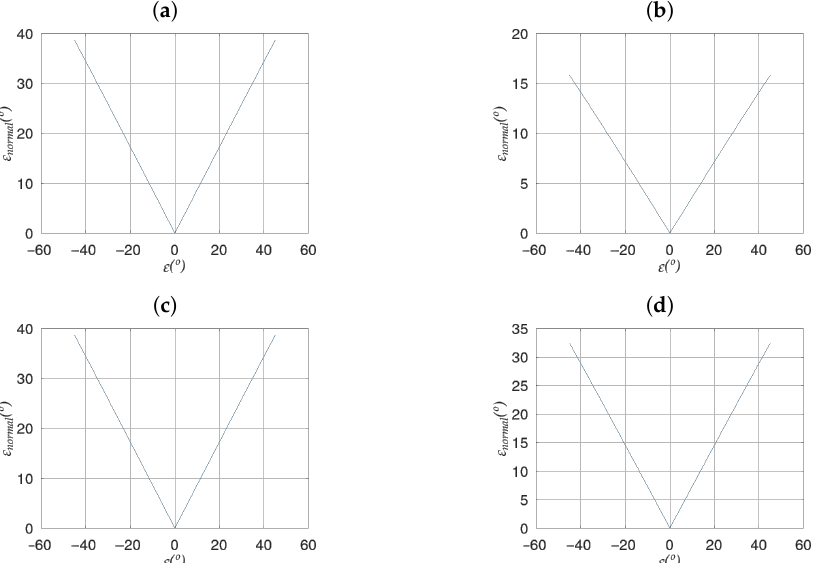
Figure 2. Deviation between the normals of the ideal and calculated planes as a function of the error in angle θ for: ( a ) Plane 1, ( b ) Plane 2, ( c ) Plane 3, ( d ) Plane 4.